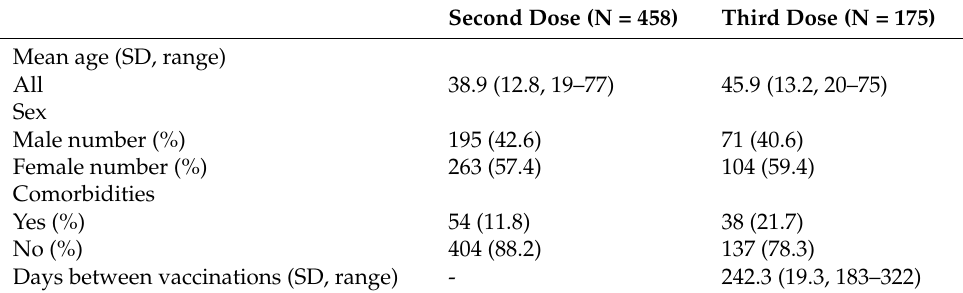
Table 1. Demographic characteristics of the research